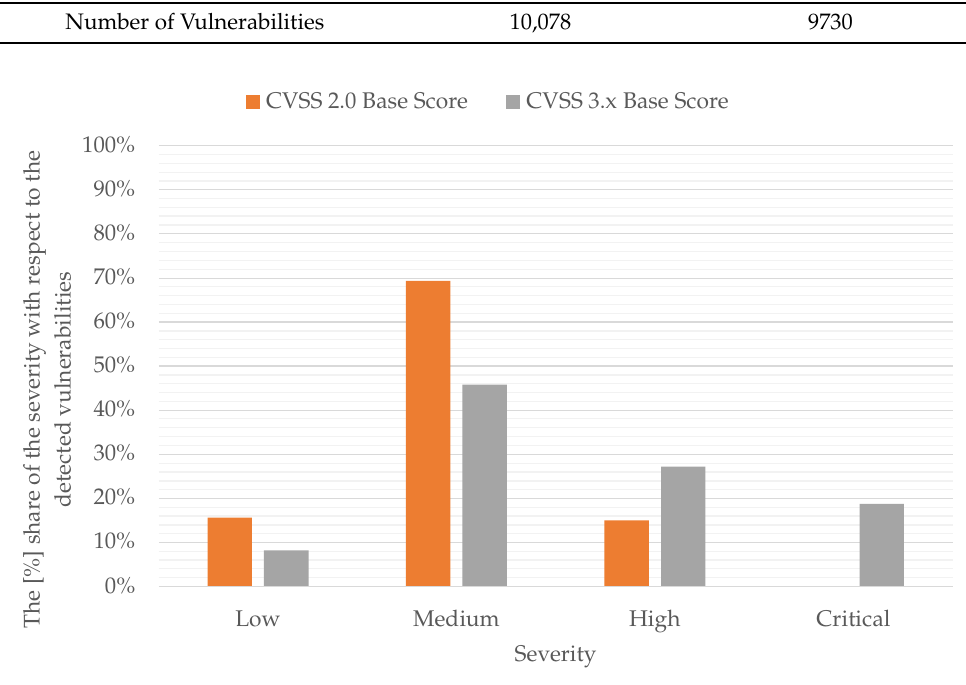
Figure 6. Vulnerability severity histogram divided into the base CVSS 2.0 and 3.x scores for environ- ment C.